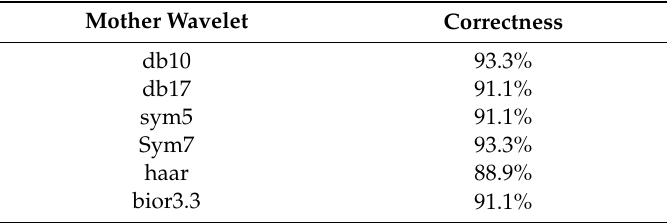
Table 4. Comparison of di ff erent mother